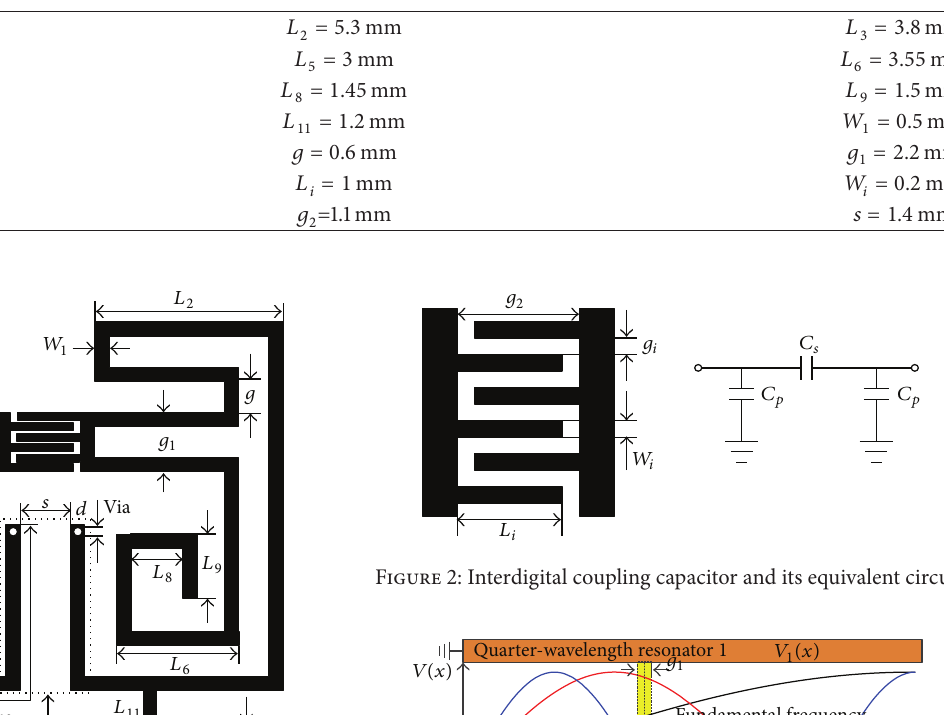
only 8.9 mm × 12.2 mm ( 0.052𝜆 𝑔 × 0.071𝜆 𝑔 ; 𝜆 𝑔 is the guided